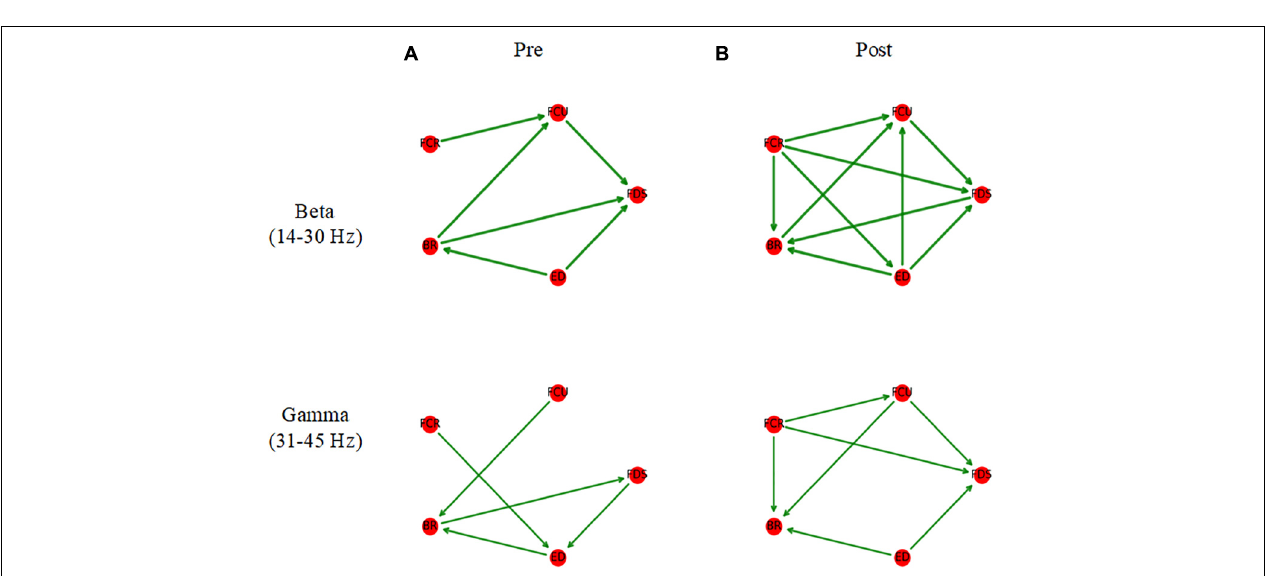
FIGURE 5 | The grand averages of the beta- and gamma-band cumulated wavelet energy for (A) EEG and (B) sEMG during the pre- and post-fatigue tasks. ∗ p < 0.05, ∗∗ p < 0.01, ∗∗∗ p < 0.001.